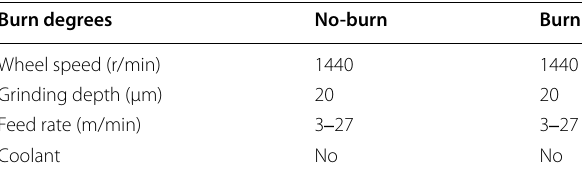
Table 2 Grinding parameters and different degrees